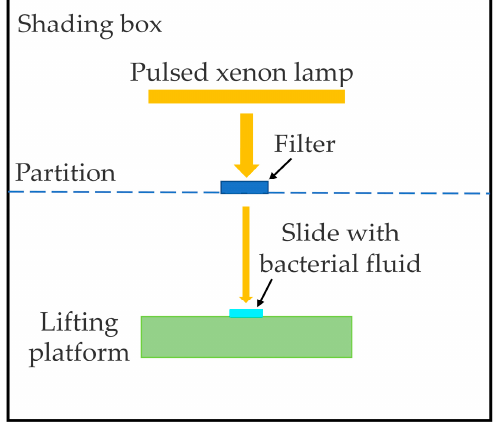
Figure 1. Schematic diagram of the experimental setup.